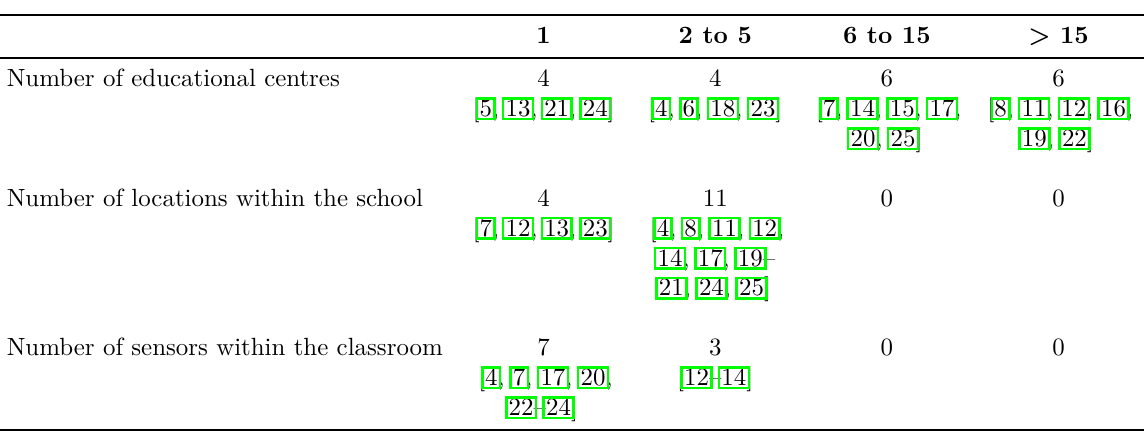
Table 1. Number of